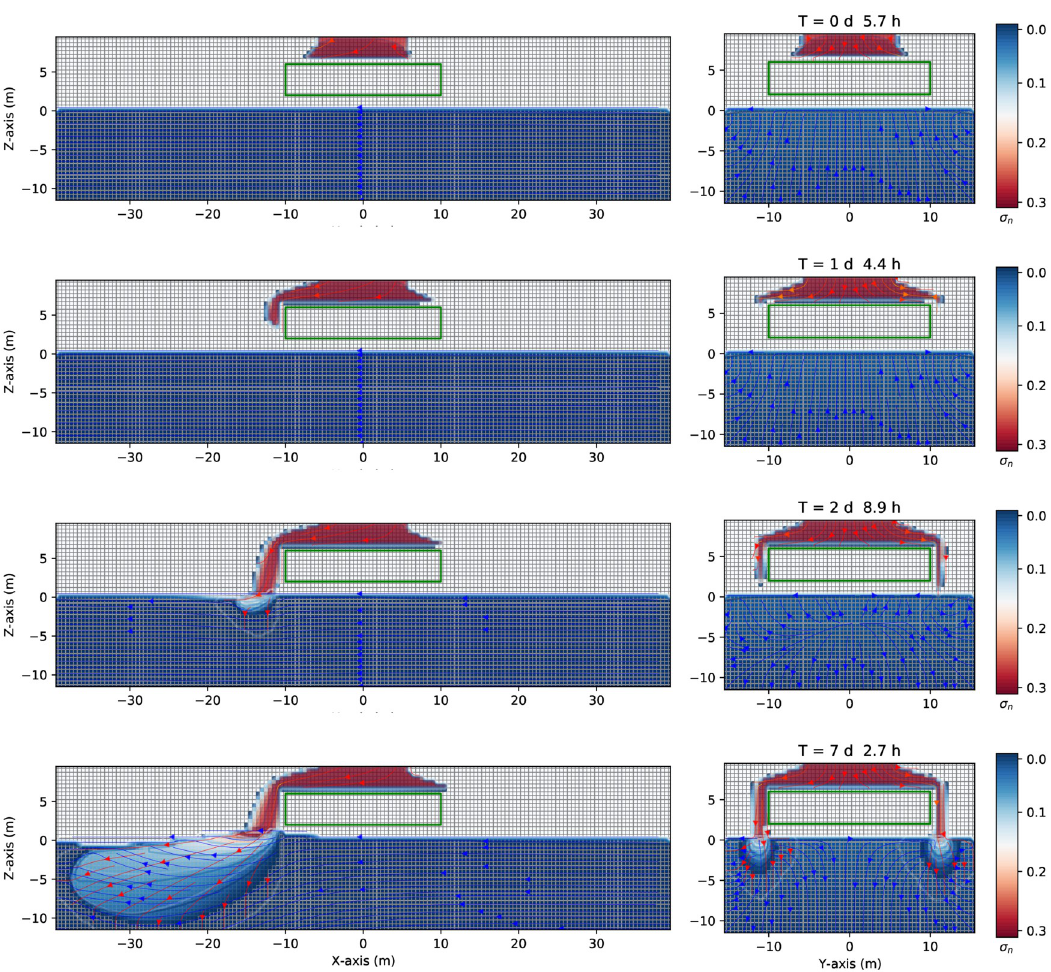
Fig 12. Saturation contours of DNAPL (with an impermeable lens) at different times. Three-dimensional numerical simulation results of the saturation contours ( σ = S ) of a three-phase immiscible fluid flow (water + a continuous source of DNAPL + air) n n ϕ using a spatial grid resolution of 0.50 m and a grid dimension of 80 m × 32 m × 22 m , at different times. The DNAPL leak encounters an impermeable obstacle (depicted in green) situated at z = [2.0,6.0] m , x = [ − 10.0, +10.0] m , y = [ − 10.0, +10.0] m . After seven days and 2.7 hours the contaminant has reached the saturated (aquifer) zone at x = − 10 m